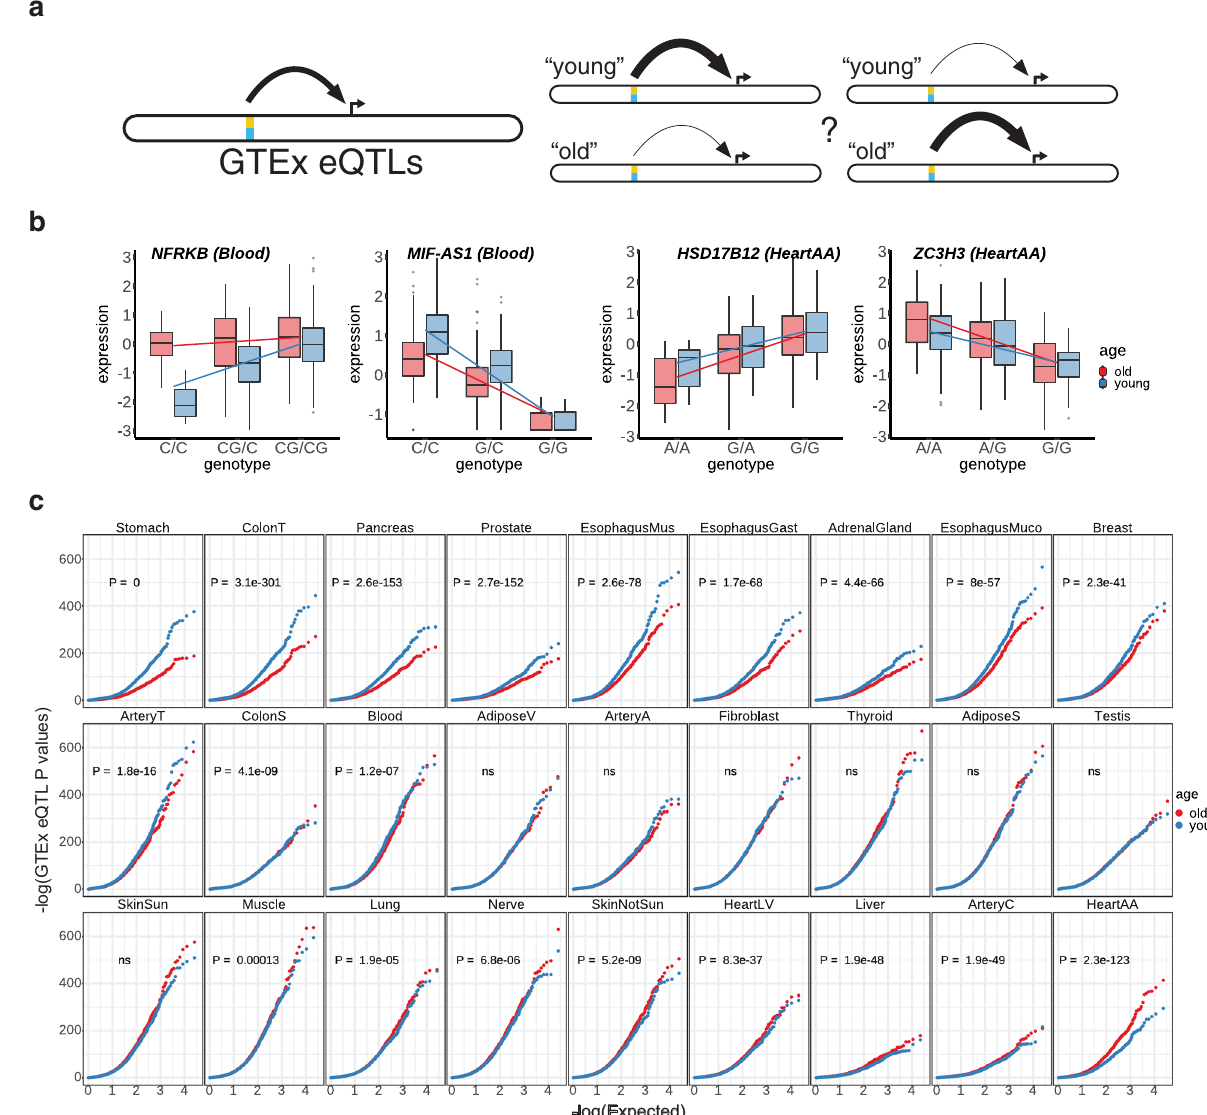
Fig. 1 | Age impacts the predictive power of eQTLs in many tissues. a A hypo- thetical model of the differing power to detect eQTLs in old and young cohorts. b Examplesofgeneexpressionbinnedbygenotypeandageforfourgenesinwhich eQTL p -values differ between old and young individuals in whole blood and heart atrialappendage.Examplegeneswithbothpositiveandnegativeeffectsareshown. n =309 samples for old group in blood, n =361 samples for young group in blood, n =202samplesforold group inheartatrial appendage, n =170samples for young